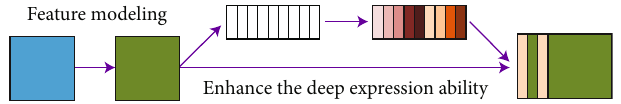
Figure 3: The schematic diagram of the channel attention mechanism.